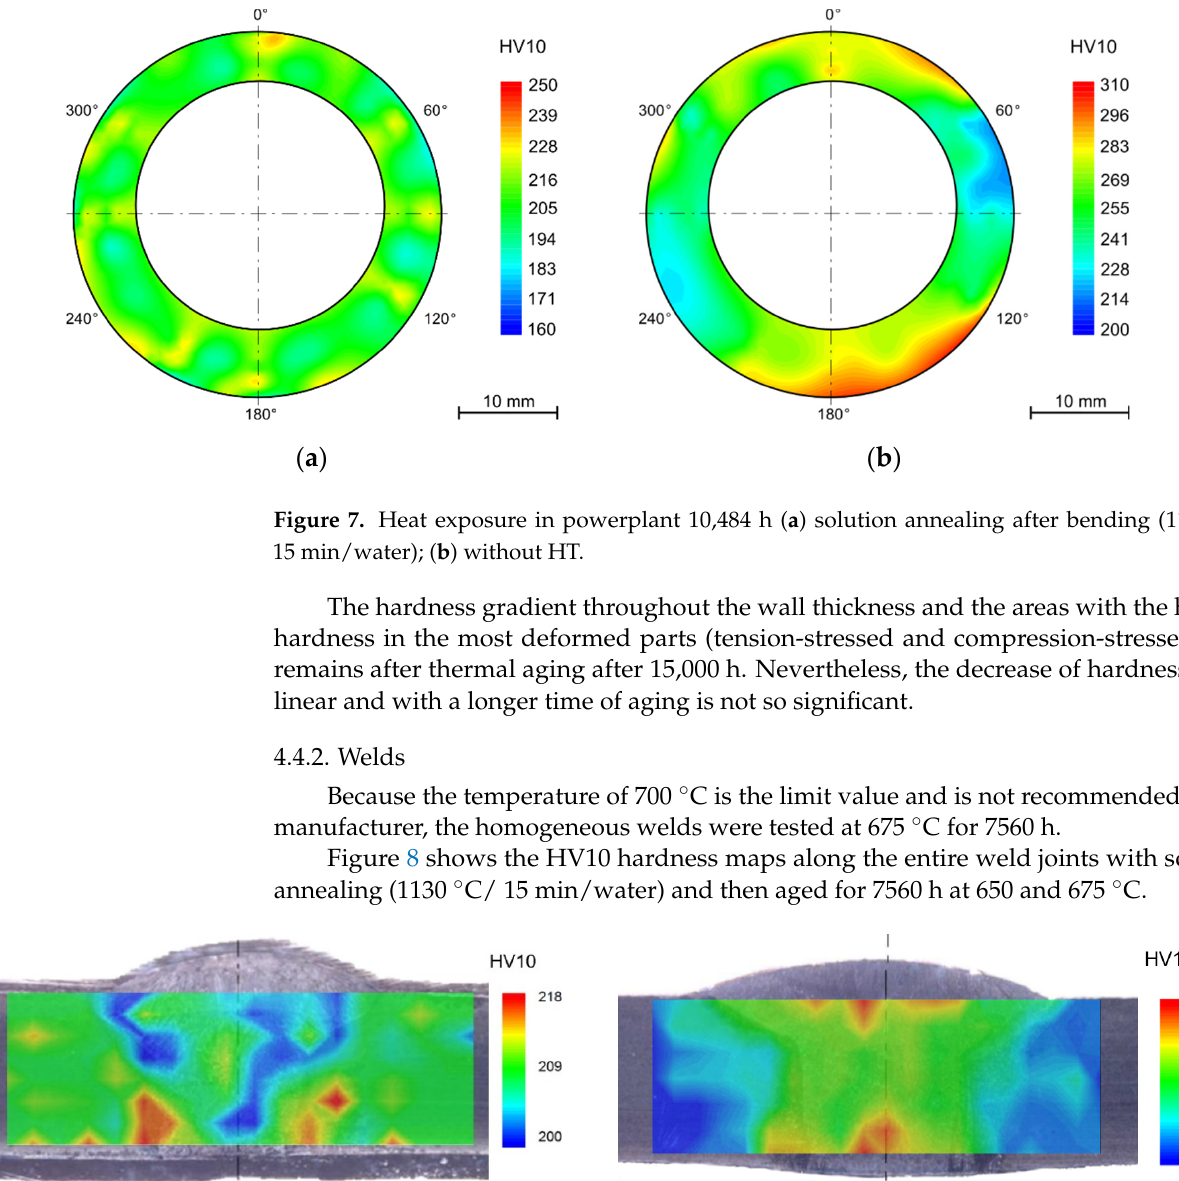
Figure 8. Hardness maps of the annealed weld joint after aging ( a ) 650 °C/7,560 h, ( b ) 675 °C/7, 560 °C.